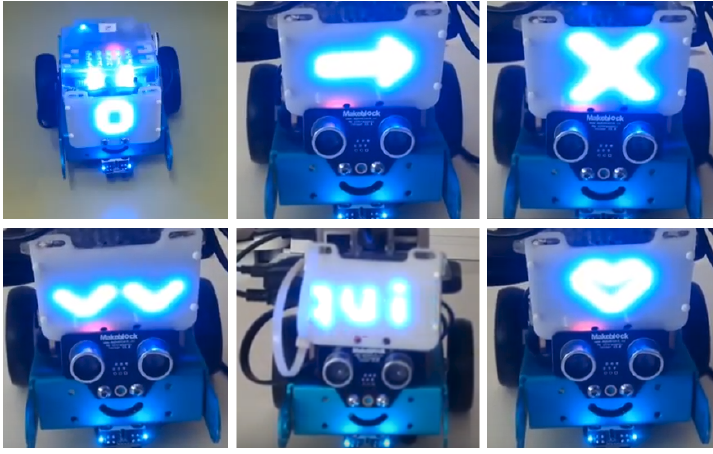
Figure 6. Practice task with the LED matrix actuator.